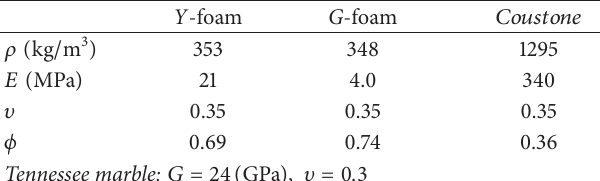
Figure 2: Effect of porosity and thickness ratio on dimensionless natural frequency.